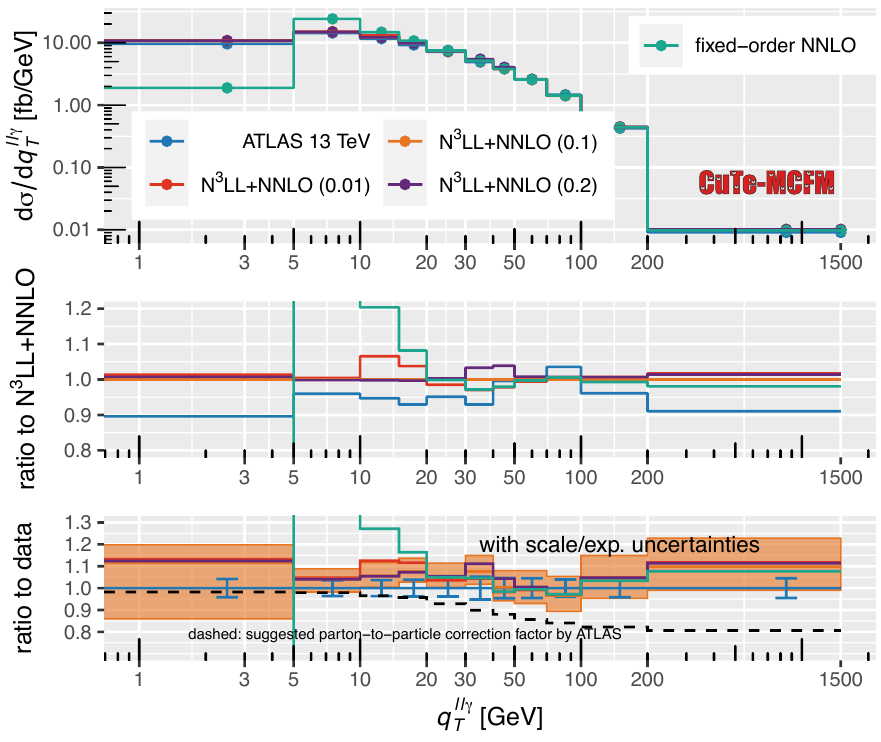
Figure 23. Comparison of N 3 LL+NNLO predictions with the ATLAS measurement of q llγ 13 TeV . Note that this plot includes the first three bins individually that are only shown combined for the NNLO fixed-order comparison in ref. [133]. The labels 0 . 01 , 0 . 1 and 0 . 2 in the plots refer to the value of x max